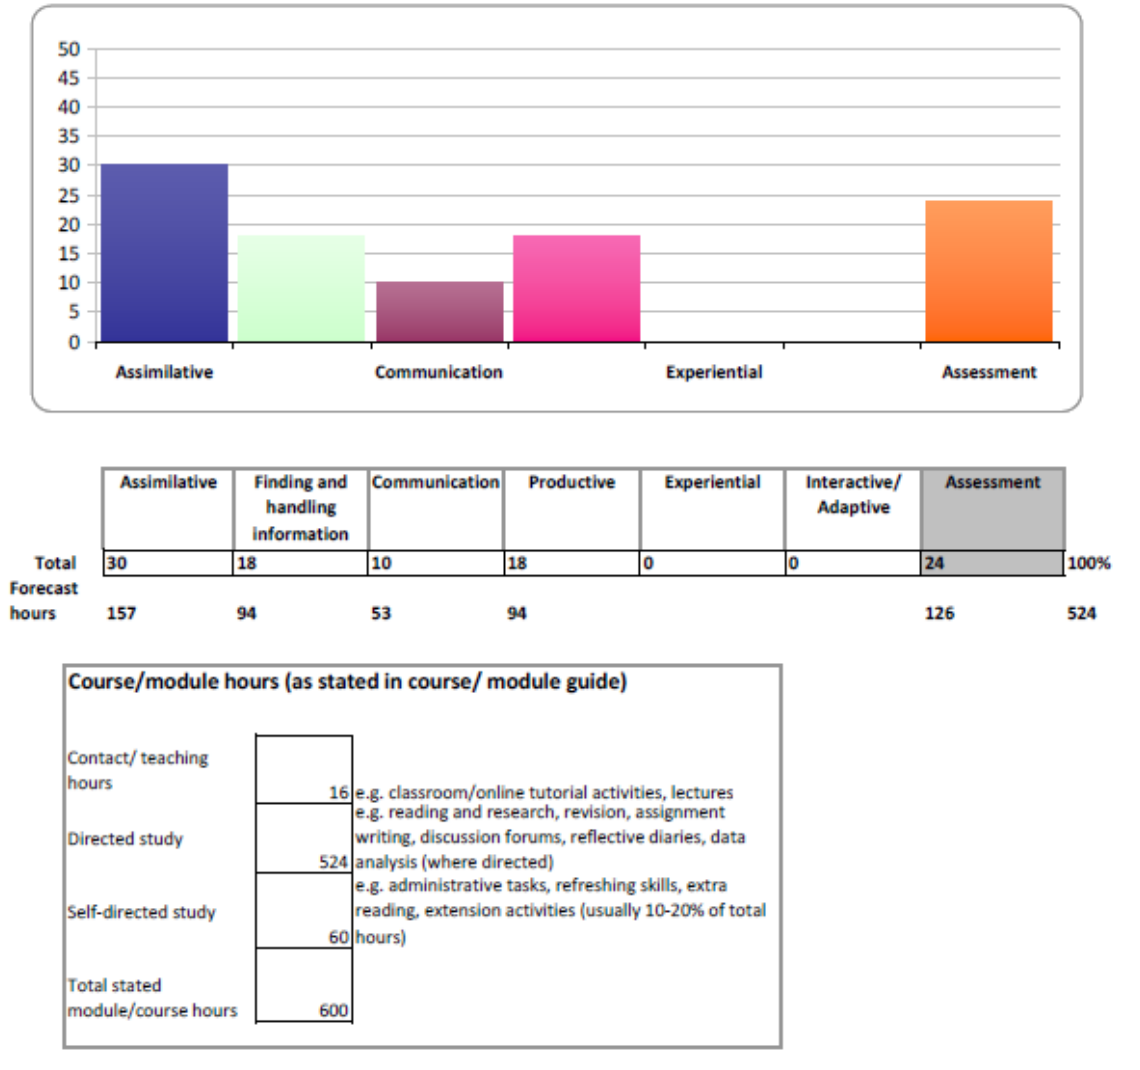
Figure 2. Activity Planner for the new planned